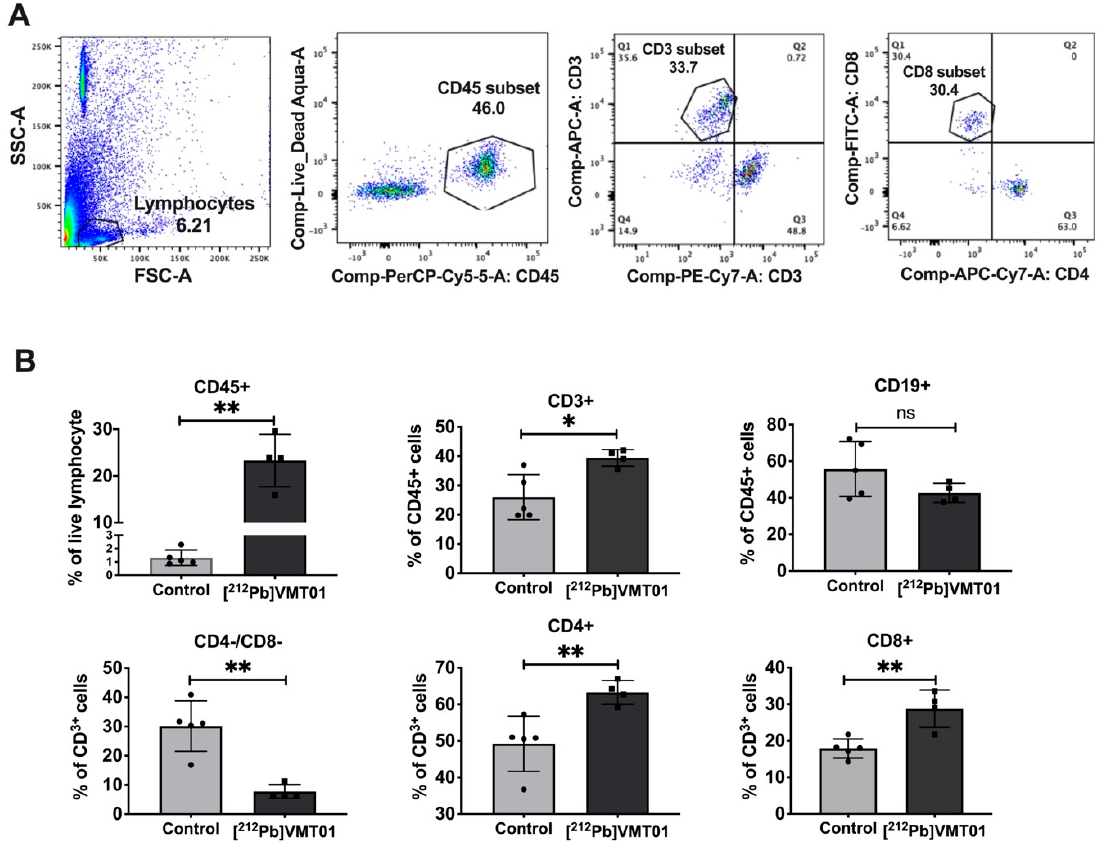
Figure 6. [ 212 Pb]VMT01 enhances tumor infiltrating lymphocytes in B16-F10 melanoma. ( A ) Lymphocytes were gated to exclude non-lymphocyte populations based on forward and side scatter (FSC and SSC) and stained for live/dead discriminator, CD45, CD19, CD3, CD4, and CD8a; ( B ) FACS analysis of CD45, CD19, CD3, CD4, and CD8a lymphocytes in control for control ( n = 5) vs. 212 Pb α‐ therapy ( n = 4) treated B16 ‐ F10 tumor. Statistical analysis: n.s. non ‐ significant; * p < 0.05; ** p < 0.01.